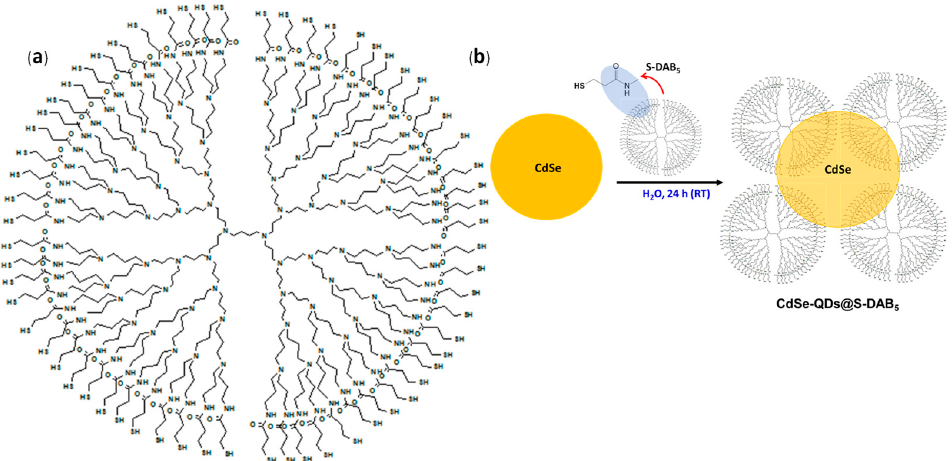
Figure 1. Scheme ( a ) S-DAB 5 and ( b ) CdSe-QDs nanoparticles coated by S-DAB 5 dendrimer (ChemWindow Chemical Structure Drawing Software from Wiley).